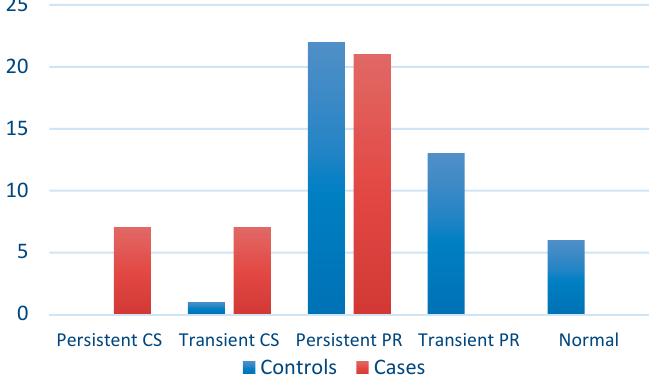
Figure 1. GMs trajectories. N = normal; CS = cramped-synchronized; PR = poor repertoire.